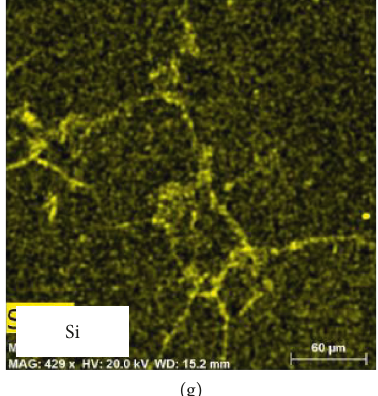
Figure 6: EDX elemental maps taken for the as-cast C3 sample with 3.0wt.%